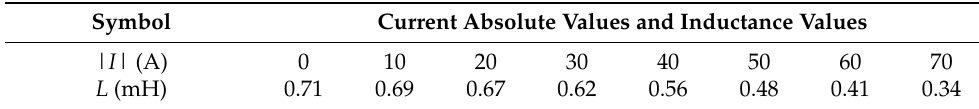
Table 1. Filter inductances at different current absolute values.